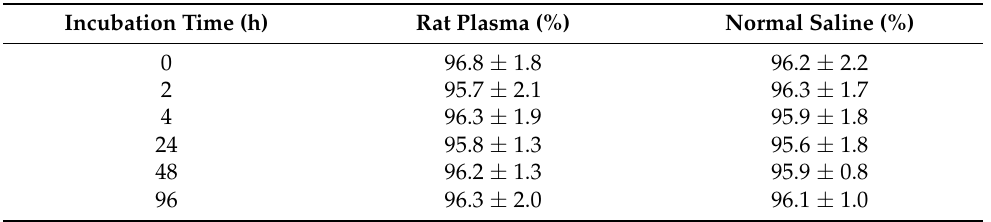
Table 1. In vitro stability of 111 In-DOTA-EB-cRGDfK at different times after incubation in normal saline or rat plasma at room temperature (mean ± SD, n =